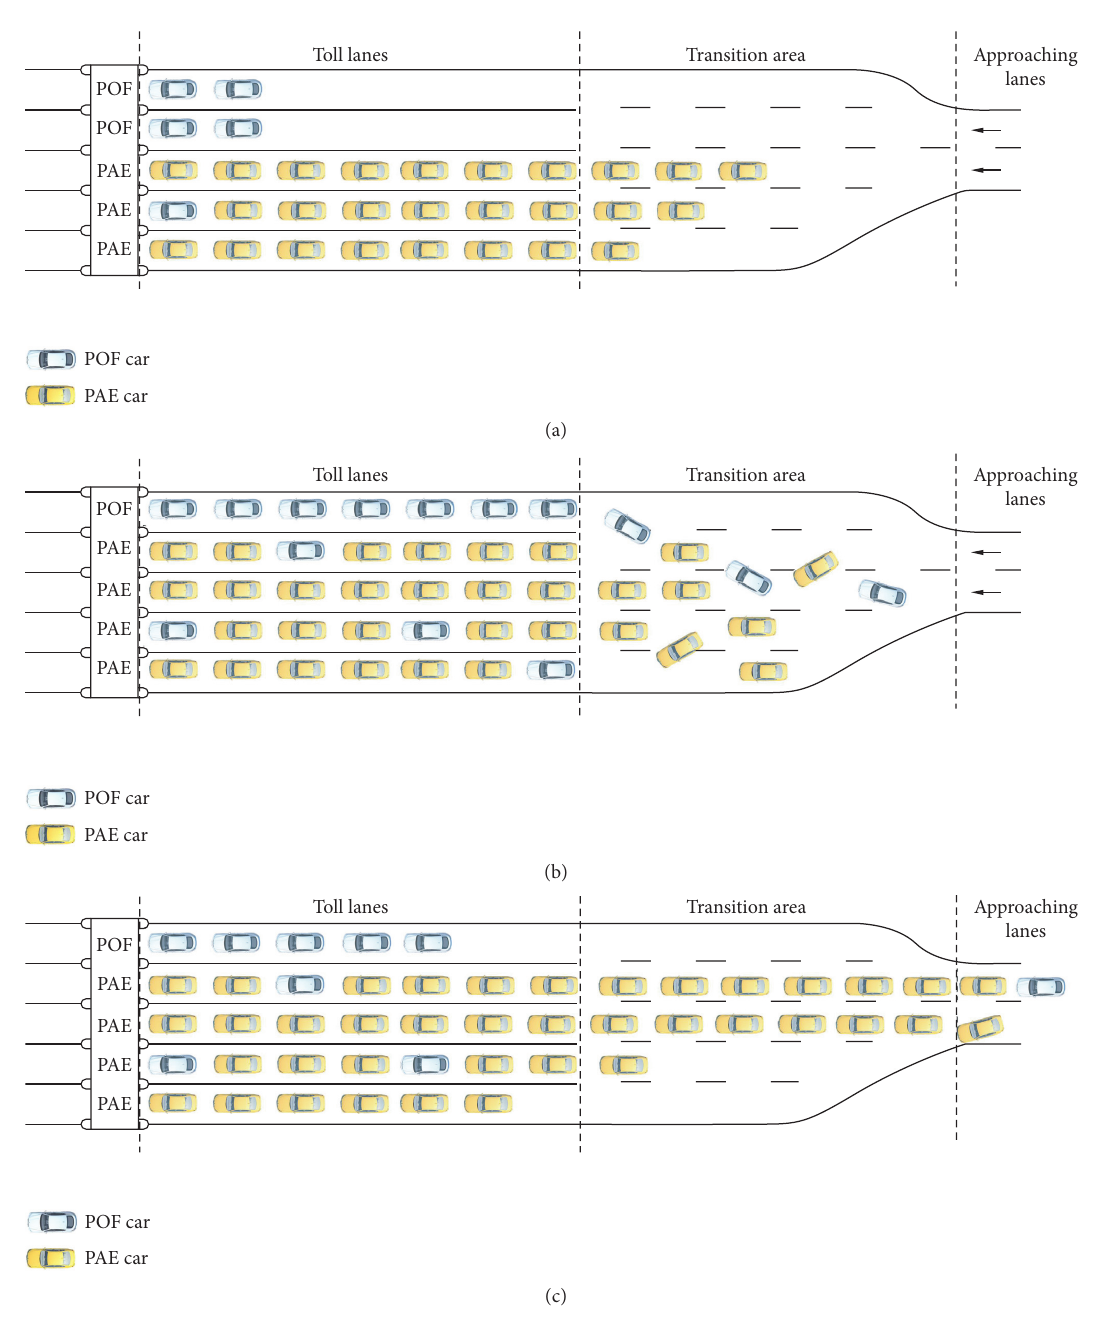
Figure 1: Causes for delays at the car park exit. (a) Queueing on the toll lanes. (b) Lane changing in the transition area. (c) Bottleneck at the approaching